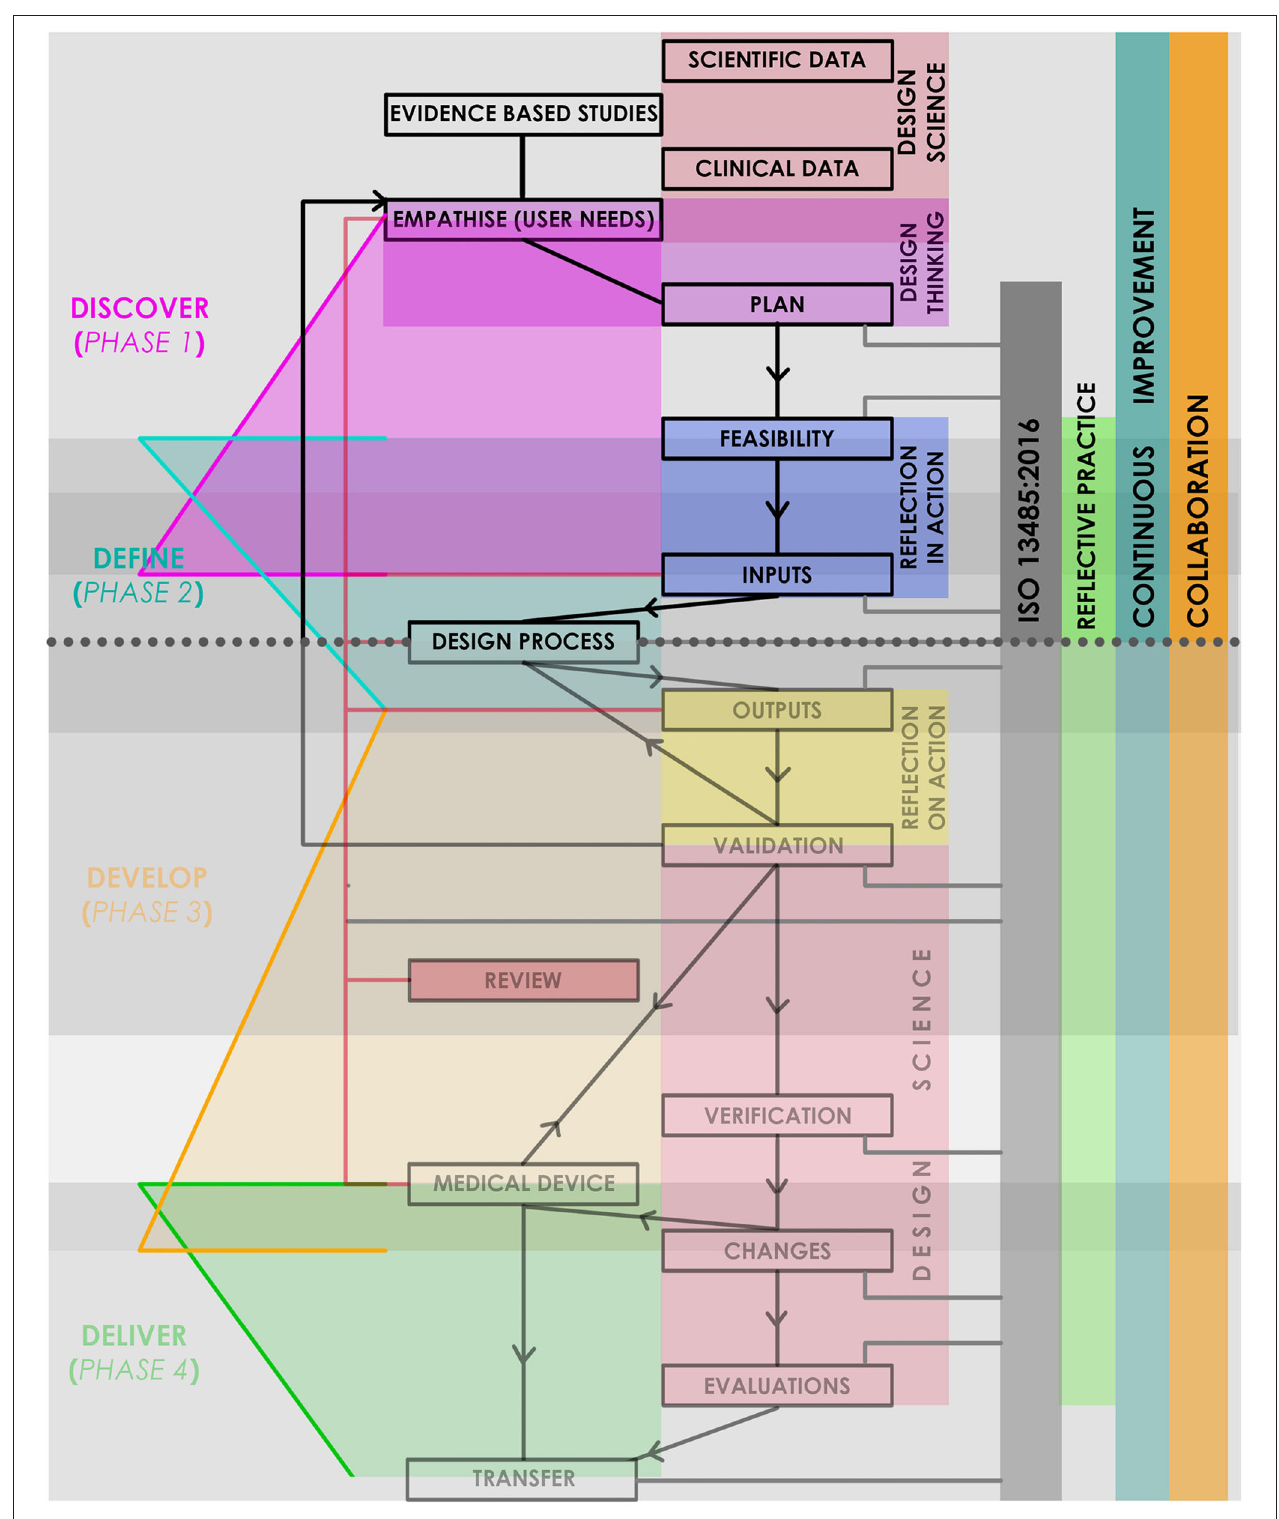
FIGURE 2 | HudPAX Medical Device Development Hybrid method.